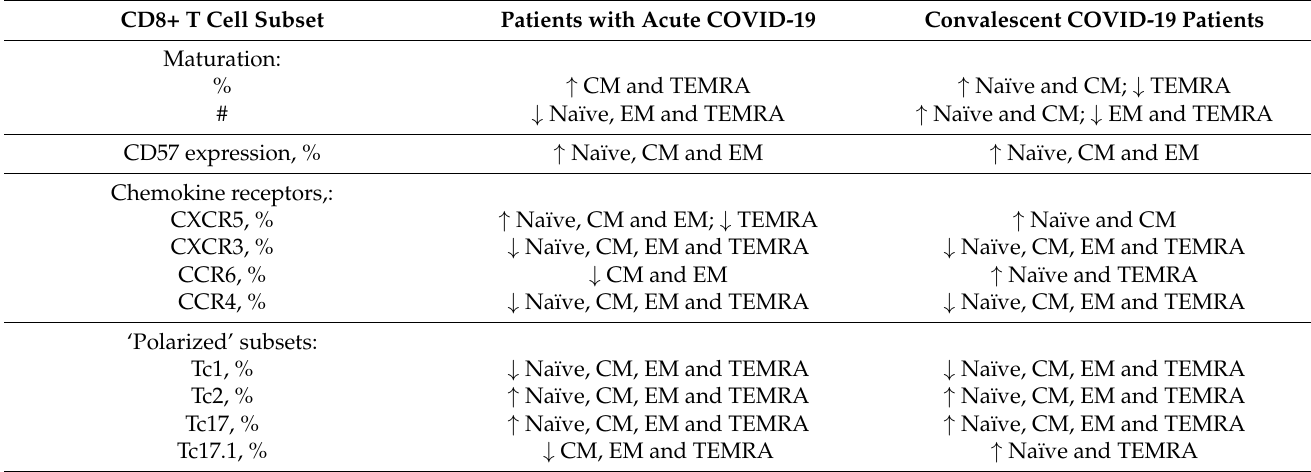
Table 2. Summary of alterations in peripheral blood CD8+ T cell subsets from acute and convalescent COVID-19